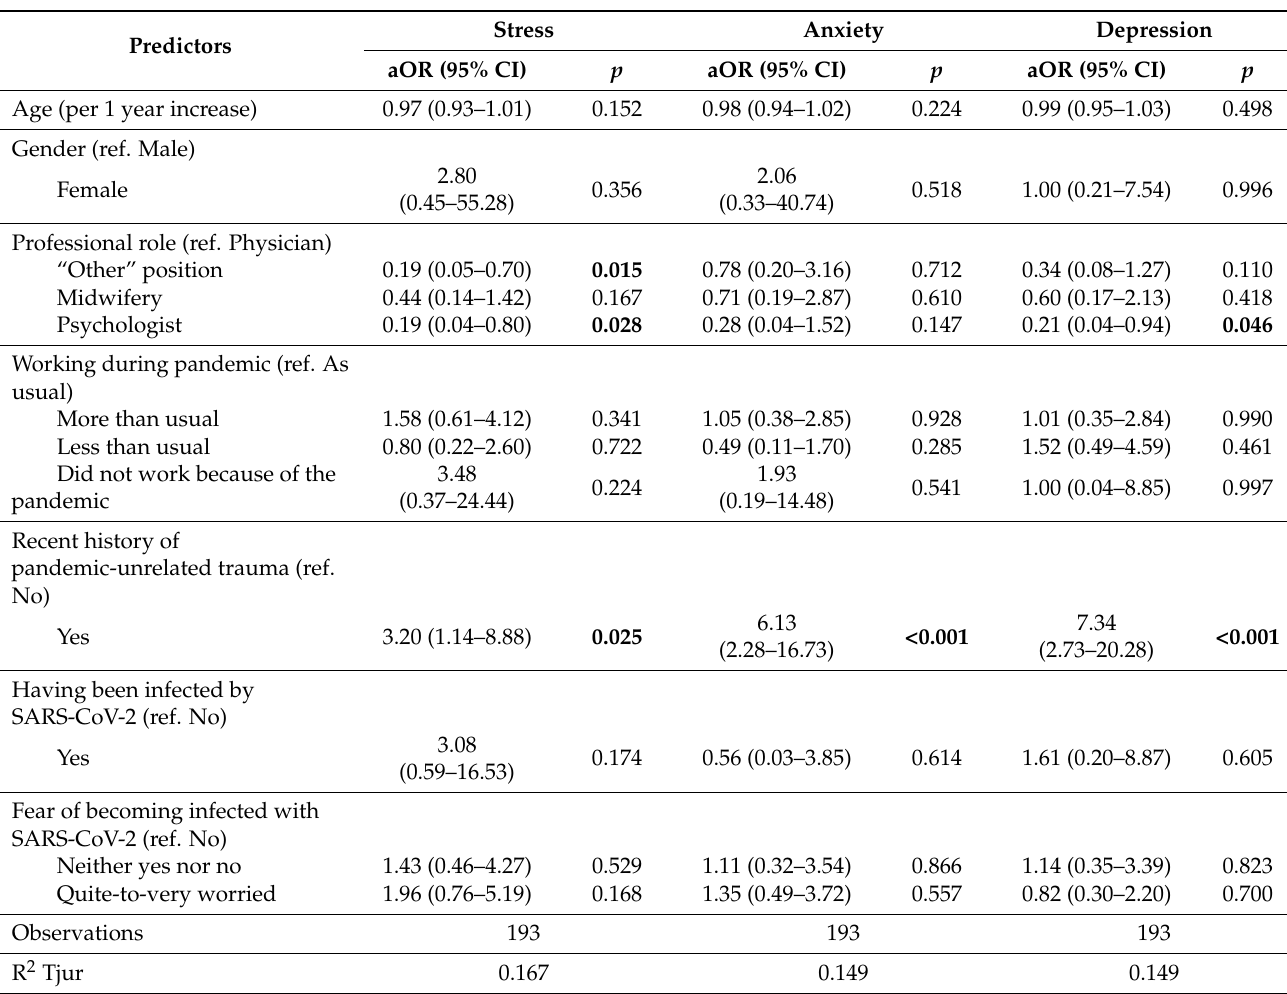
Table 4. Adjusted odds ratios and confidence intervals of the associations with stress, anxiety, and depression.